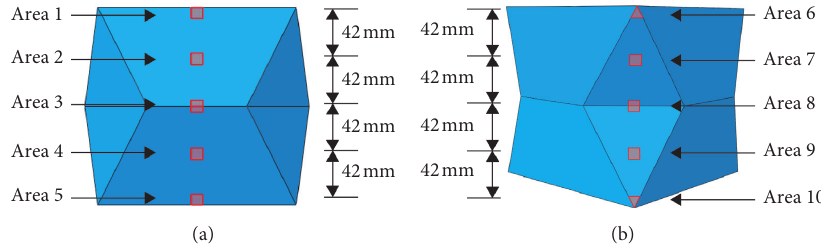
Figure 6: Analysis area of the energy absorption device: (a) concave side; (b) convex side.